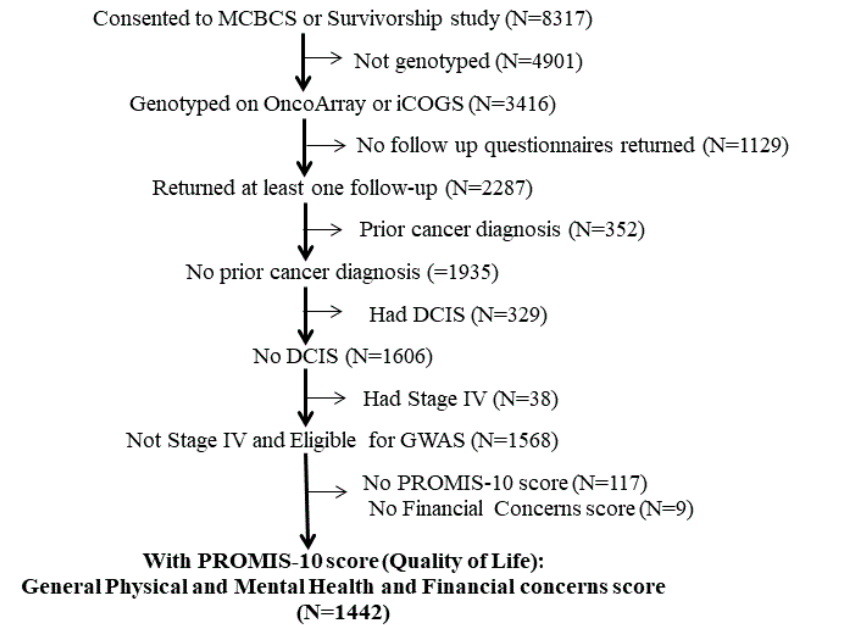
Figure 1. Breast Registry Flow Diagram. Table 2. Multivariable regression analysis: Factors related to HRQOL in the MCBDR.